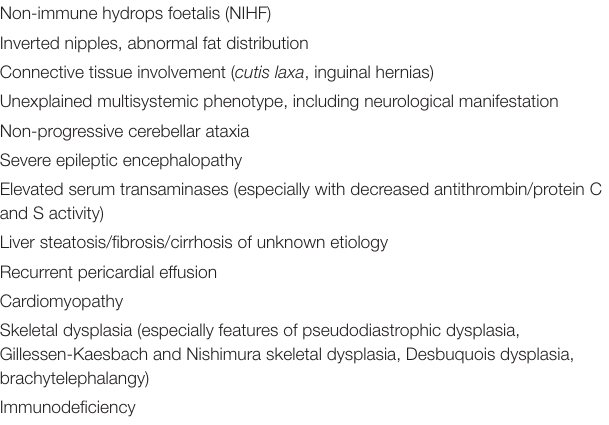
TABLE 1 | Clinical and biochemical features requiring IEF of serum